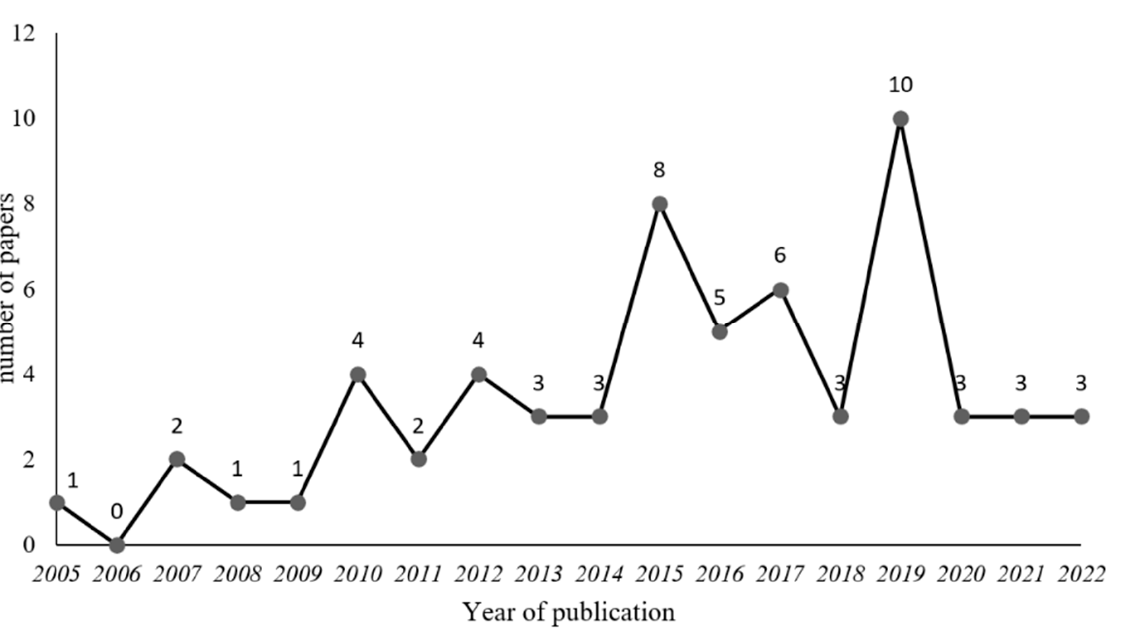
Figure 2. The annual number of publications on PPP operational risk from 2001 to 2022.